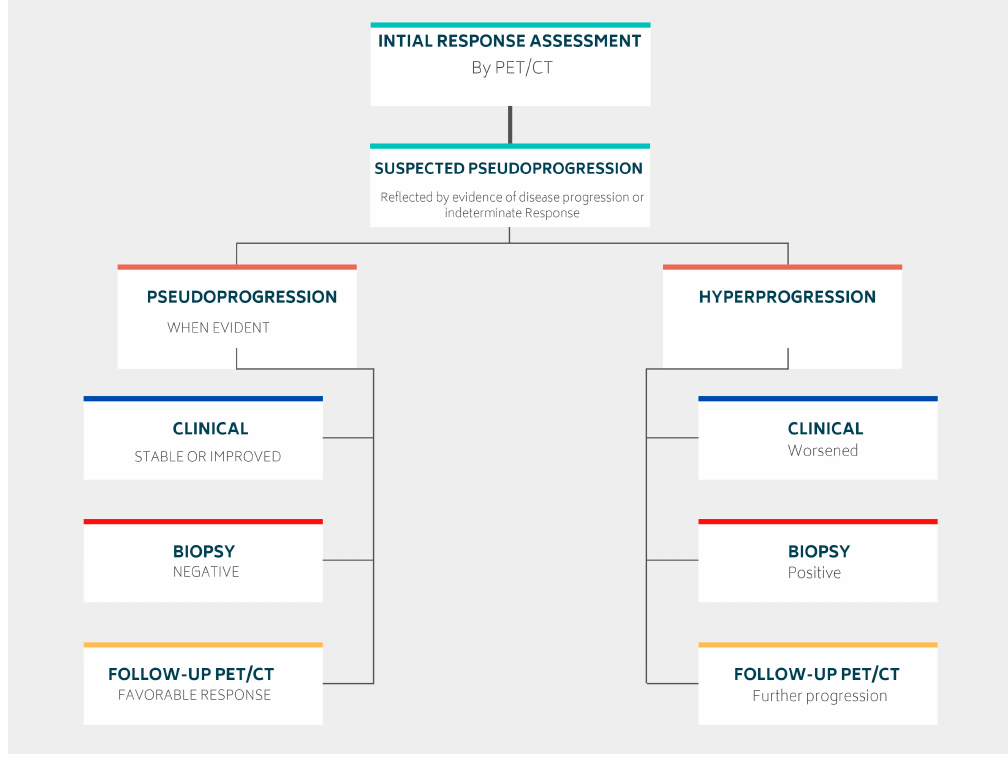
Figure 5. Schematic showing clinical, histopathological, and imaging differences between pseudo- progression and hyperprogression.